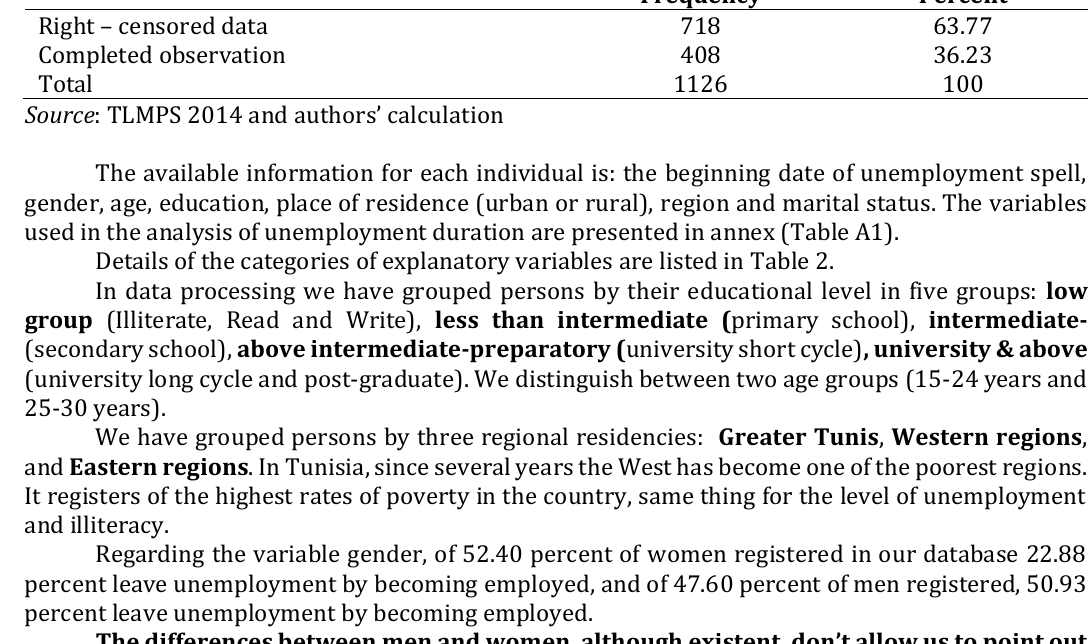
Table 1: Employment status of unemployed individuals Frequency Percent Right – censored data 718 63.77 Completed observation 408 36.23 Total 1126 100 Source : TLMPS 2014 and authors’